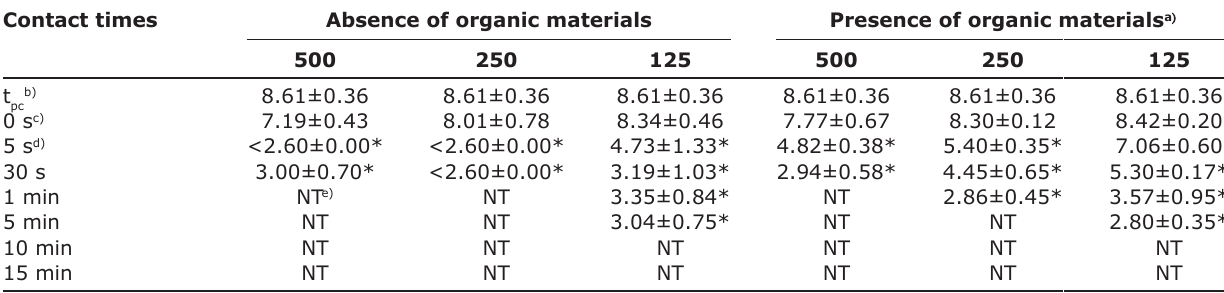
Table-2: The bactericidal efficacy of DDAB against E. coli in the absence or presence of organic materials. Contact